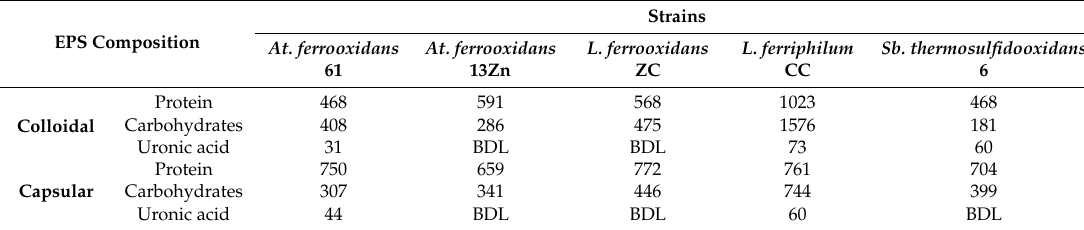
Table 5. EPS composition ( µ g/L) of bacteria grown on